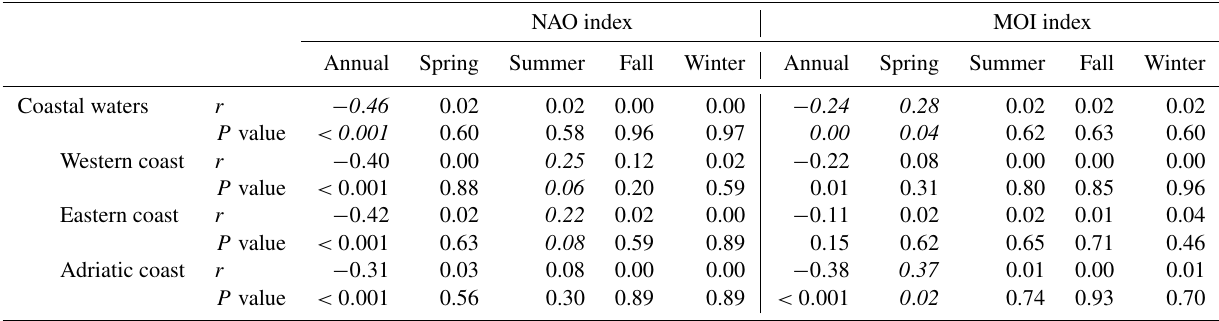
Table A1. Correlations between yearly and seasonal total carbon fixation anomalies ( (cid:54) PP) for the coastal Mediterranean waters and its sub-basins with the climatic indices NAO and MOI.